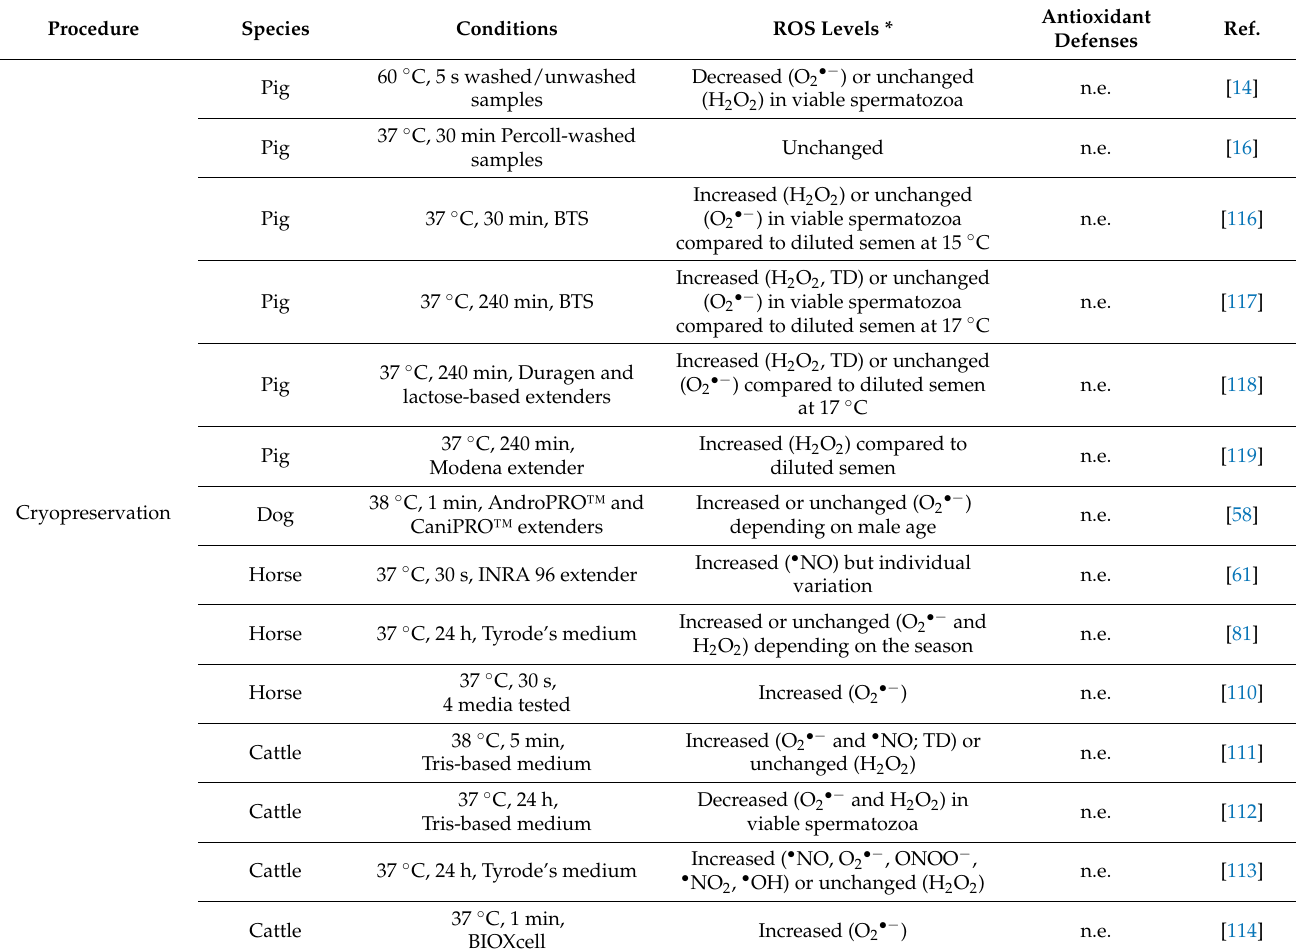
Table 2. Impact of assisted reproductive techniques on the sperm redox status in domestic